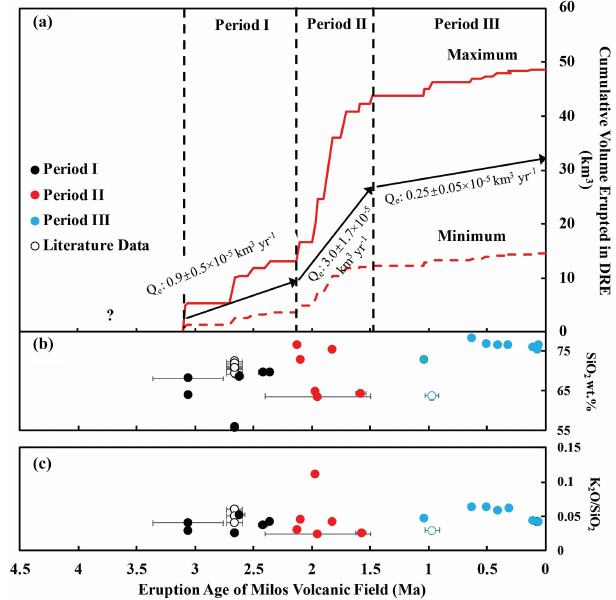
Figure 11. Eruption age vs. (a) cumulative eruption volume for the volcanic deposits of Milos, (b) SiO 2 wt% and (c) K 2 O / SiO 2 , of the Milos volcanic units of this study and previous studies. The maximum (red line) and minimum (dashed red line) cumulative eruption volume curves were estimated from Campos Venuti and Rossi (1996) and Stewart and McPhie (2006). Q e is the long-term volumetric volcanic output rate (see discussion). The exact volume of volcanic products between 4.1 and 3.08Ma is not well constraint and indicated with a question mark. The major-element data of the old pumices of Filakopi volcanoes (2.66Ma) are from Stew- art (2003). The major-element data of the Plakes lava dome is from Fytikas et al. (1986). Geochemical data of the old pumices of Prof- itis Illias ( ∼ 3.08Ma) is lacking due to the severe